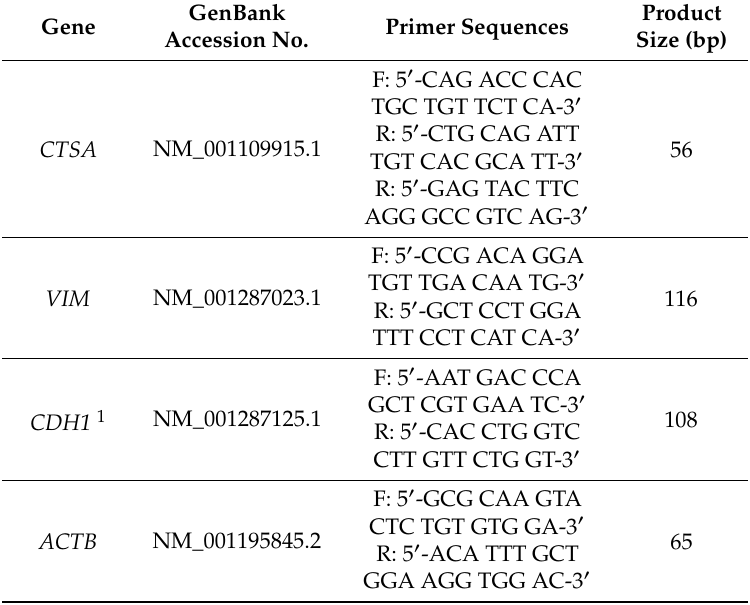
Table 2. Primers and their sequences used in this study. 1 CDH1 is also known as E-cadherin . GenBank Gene Accession